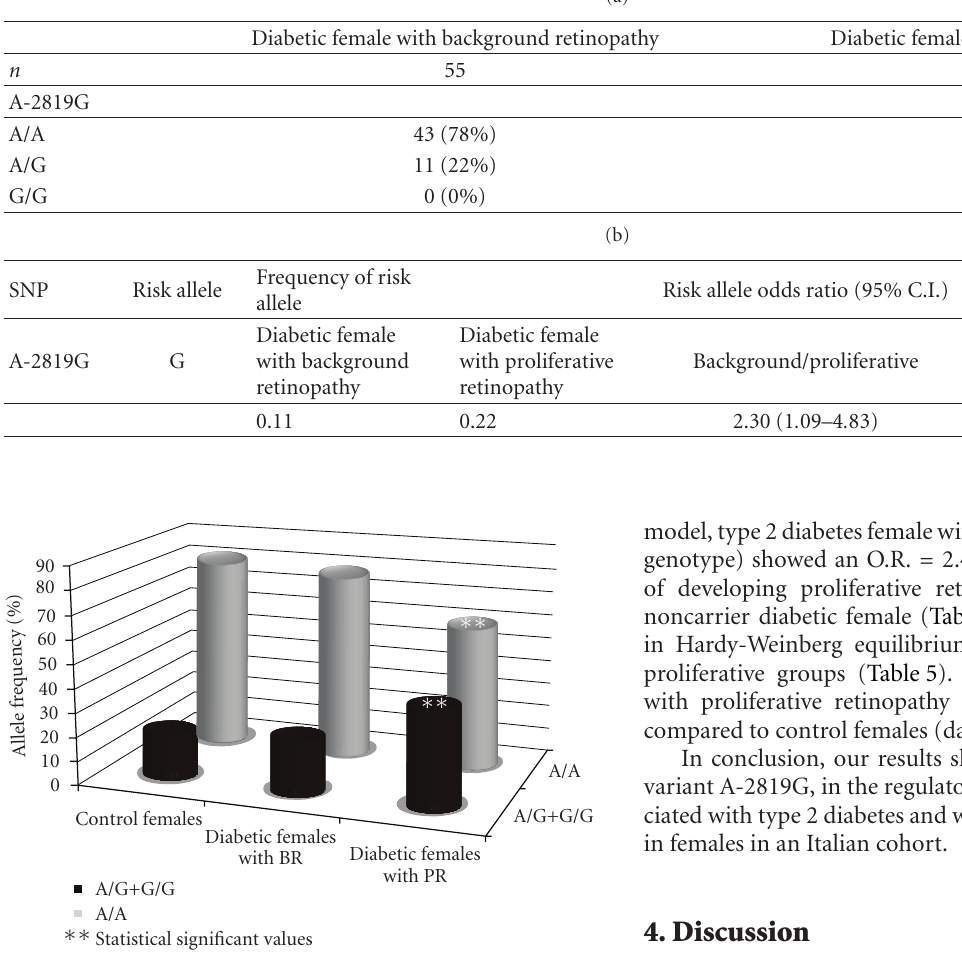
Figure 1: Comparison of A-2819G frequencies in diabetic women with background or proliferative retinopathy and control